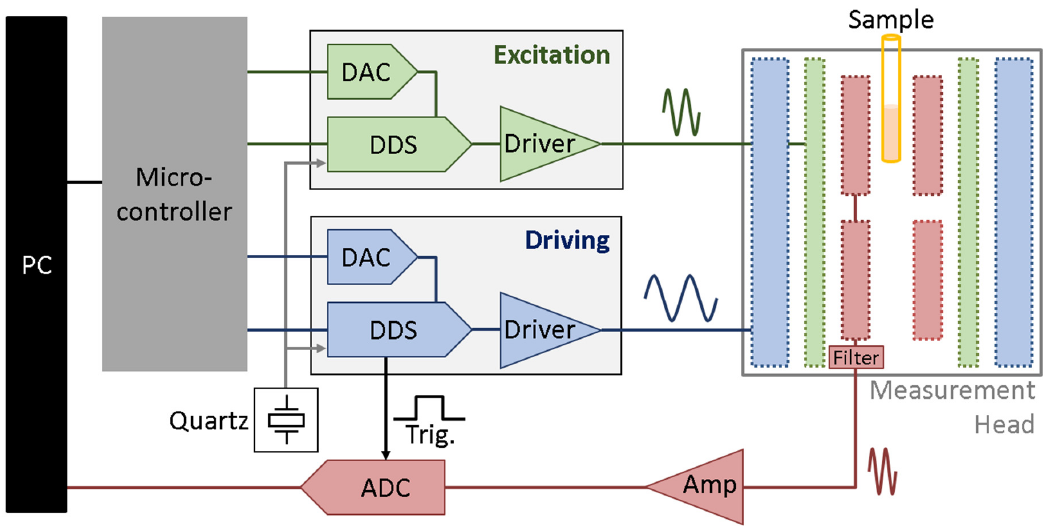
Figure 1. Schematic overview of the magnetic frequency mixing detection setup. A PC is controlling the magnetic reader which consists of a microcontroller, two direct digital synthesis (DDS) chips, digital to analogue converters (DAC), drivers, preamplifier and filters. A schematic cut of the measurement head is shown with the excitation (green) and driving (blue) field coil. Also, the sample (orange) inside one section of the differential detection coil (the measurement coil) is shown. The output of this detection coil is connected via filters and preamplifier (Amp) (inside the magnetic reader) to a measurement card. Additionally, there is a connection from the driving DDS of the magnetic reader to the analogue to digital converter (ADC) for a triggered recording.